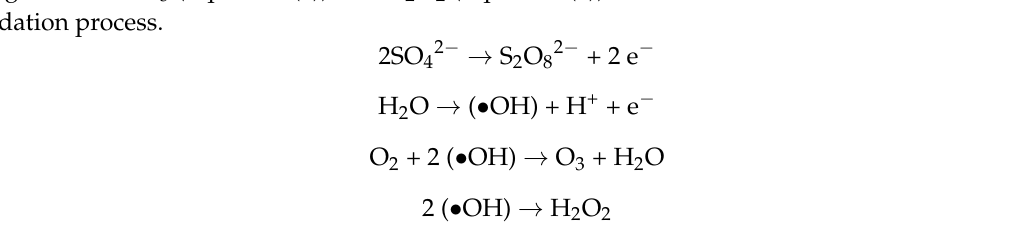
Figure 1. Oxidation trends of the antibiotics amoxicillin (AMX) ( ▲ , ∆ , ▲ ) and ampicillin (AMP) (  ,  ,  ) ( a ) and of total organic carbon (TOC) ( b ) with the electric charge passed during the electrolysis carried out in sulphate media (3 g L -1 of Na 2 SO 4 ) at three current densities: 15 (black symbols), 30 (white symbols), and 60 (grey symbols) mA cm -2 . Initial concentration was 100 mg L -1 of AMX and 100 mg L -1 of AMP.